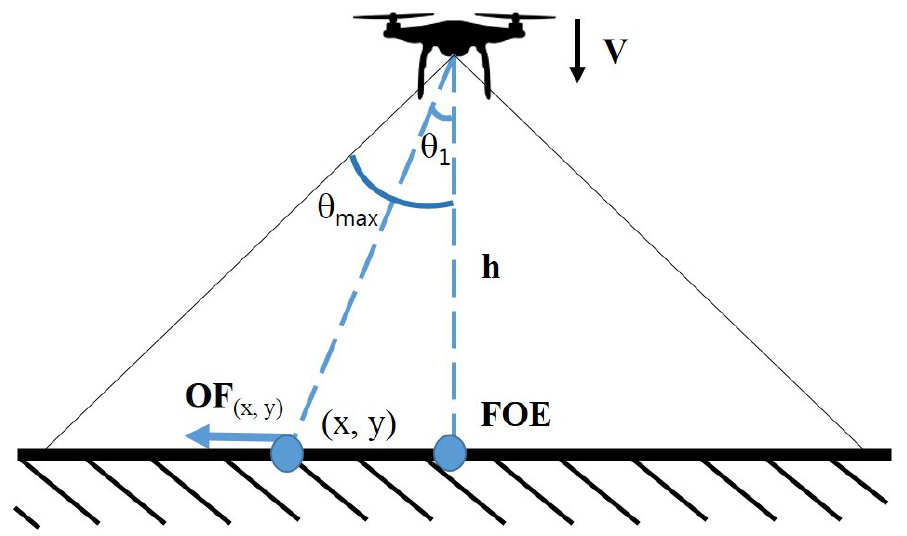
Figure 4. Examples of optical flow magnitude map.